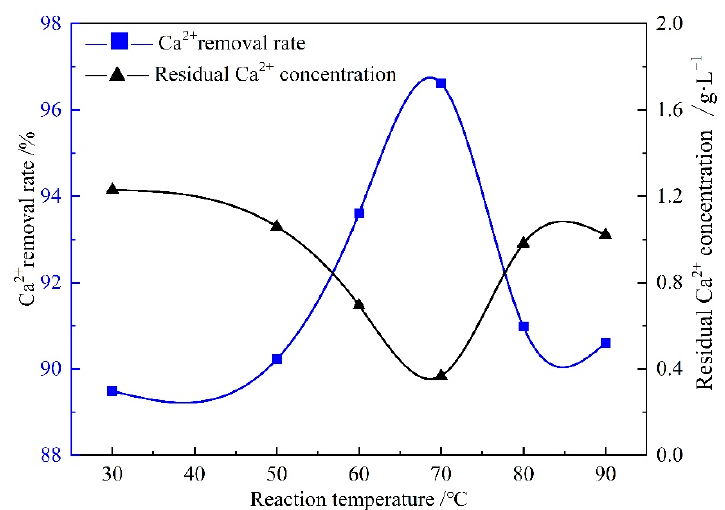
Figure 5. The relationship between reaction temperature and Ca 2+ removal rate.